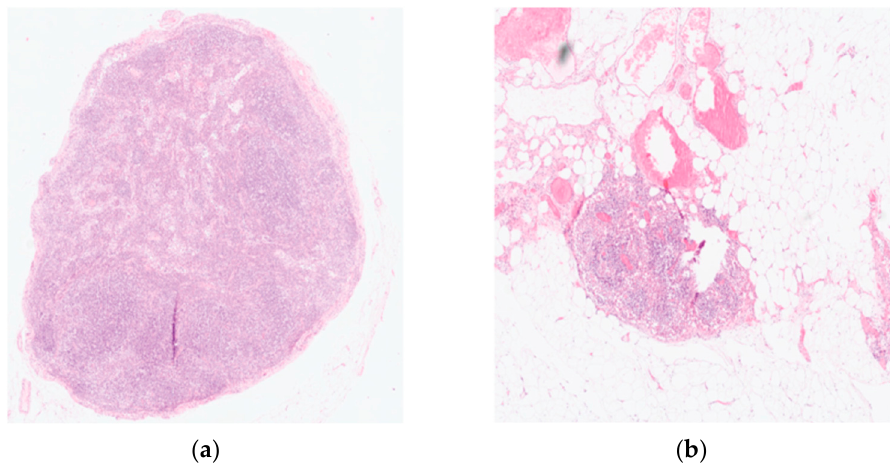
Figure 4. Histopathological workup of a resected lymph node using Hematoxylin and Eosin (HE) staining. ( a ) Tumor-free lymph node ( b ) Lymph node metastases showing a complete response after neoadjuvant treatment. Original magnification 200 ×